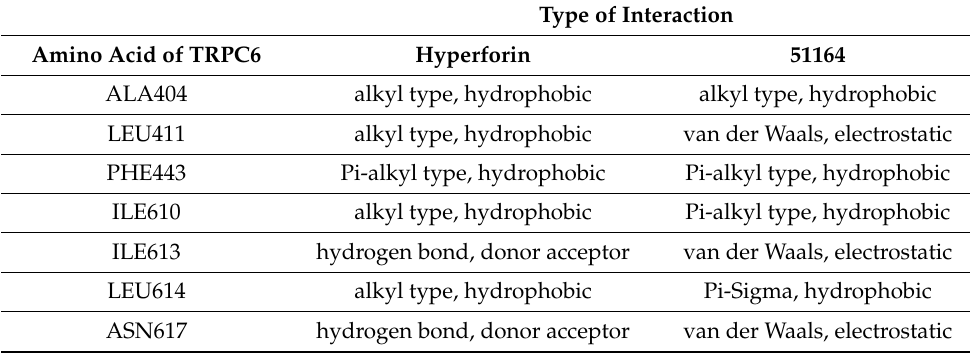
Table 2. Type of interaction of hyperforin and 51164 with amino acids forming a Ca 2+ -permeable pore of